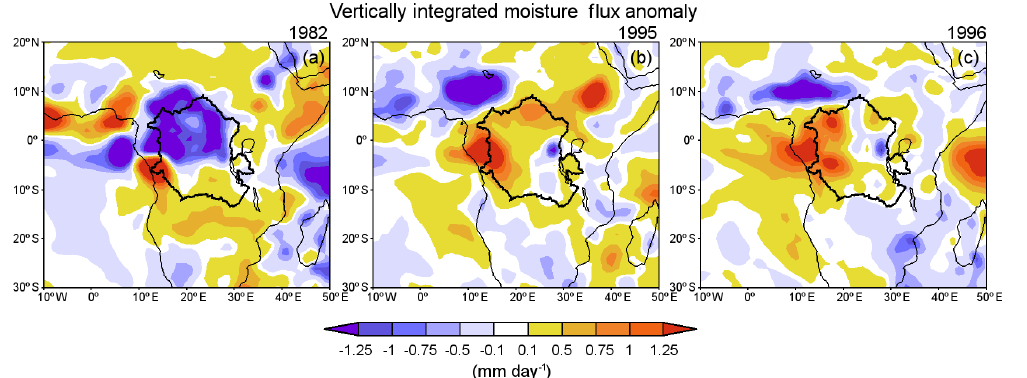
Figure 15. Anomaly of the vertically integrated moisture flux (VIMF) in 1982 (severe wet year, a ), 1995 (severe dry year, b ), and 1996 (extreme dry year, c